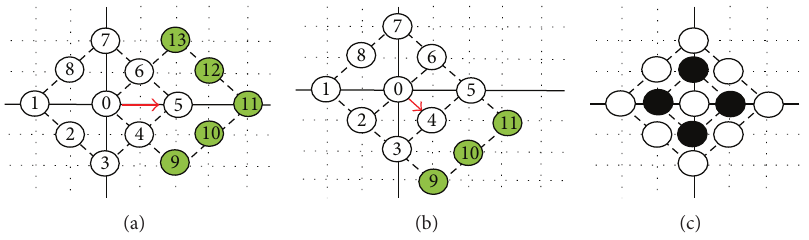
Figure 5: (a) The corner point. (b) DS along the edge point. (c) The minimum in the center point.